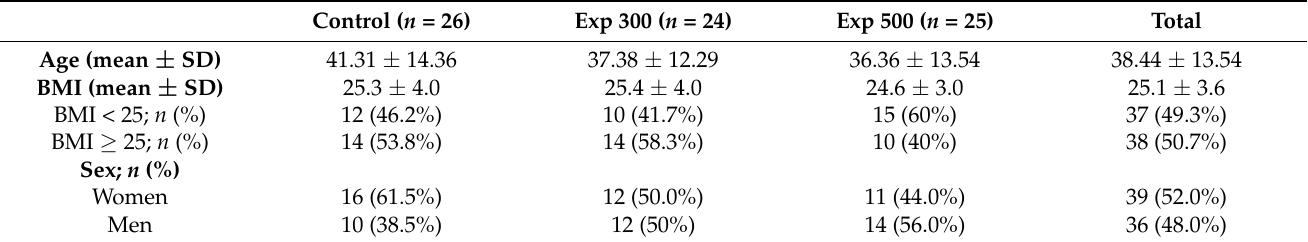
Table 1. Demography characteristics of the 75 subjects who finished this study by group.